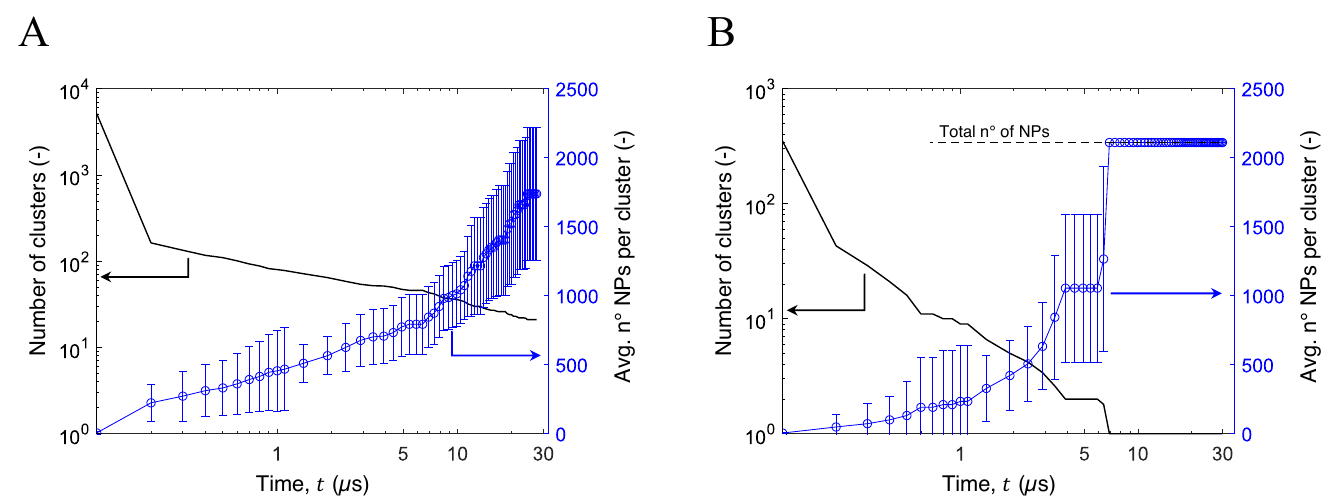
O , and ( B ) Ti O with φ = 7%, reporting the total 111 222 985 1970